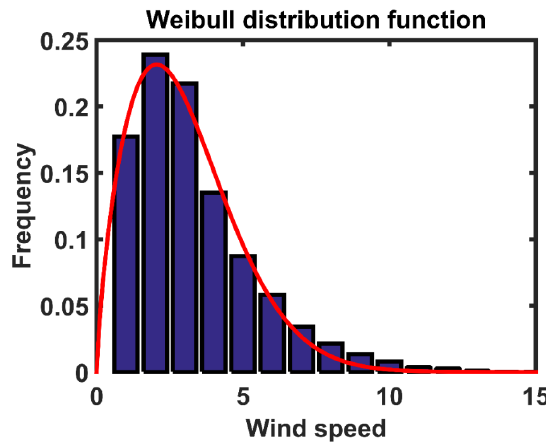
Figure 1. Weibull probability distribution function.